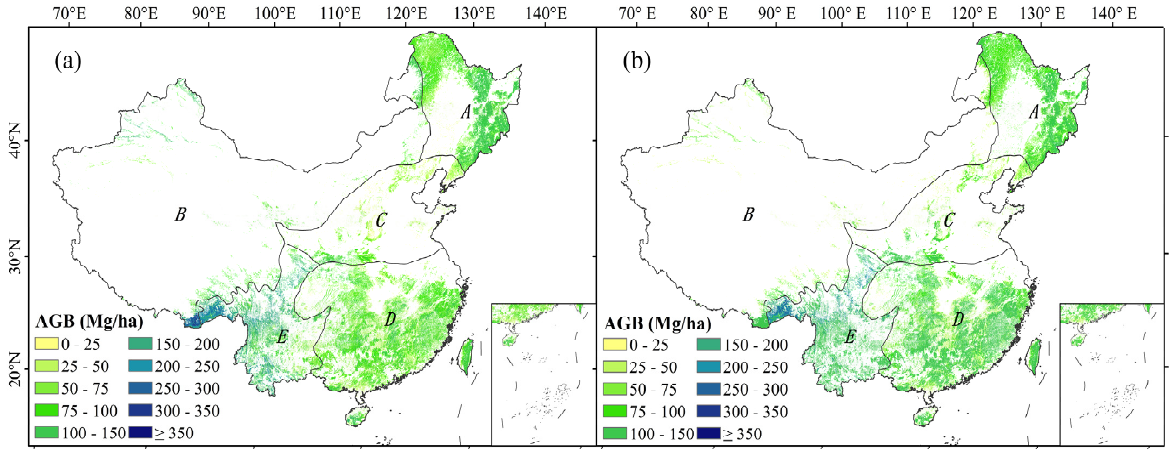
Figure 5. The distribution of forest AGB maps derived using the ( a ) WT and ( b ) RF approaches. The white blank areas are nonforest regions.